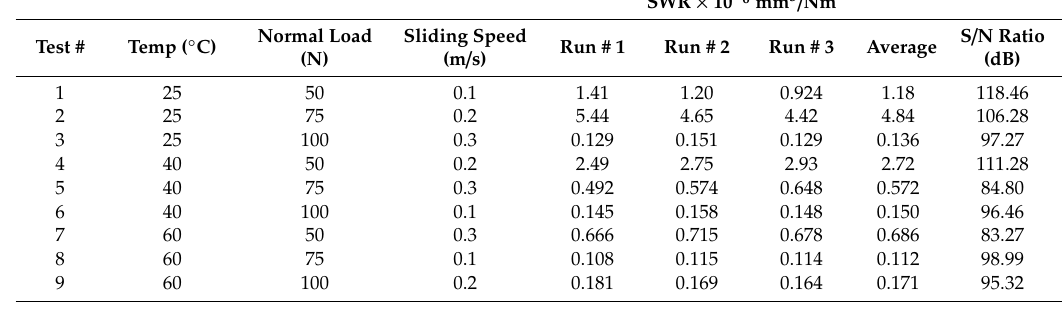
Table 4. Experimental results for SWR and the corresponding S / N ratios.